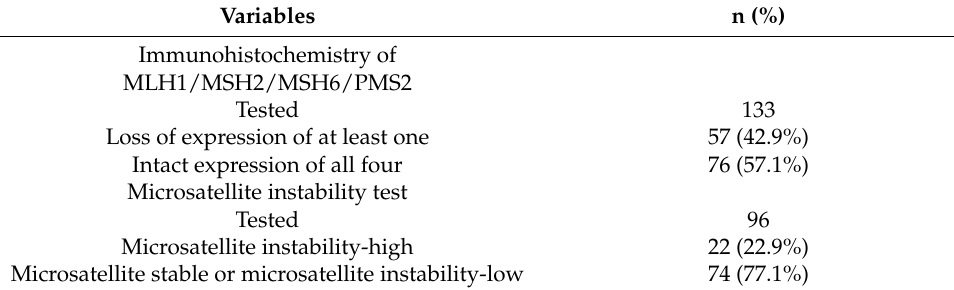
FIGO, International Federation of Gynecology and Obstetrics; LS, Lynch syndrome. * Lynch syndrome-associated cancers: colorectal, ovarian, stomach, pancreatobiliary, urinary tract, small bowel, and brain (usually glioblastoma) cancer; sebaceous carcinoma, keratoacanthoma. ** Family history of Lynch syndrome-associated cancers within second-degree relatives. Thirty patients (14.7%) were found to have pathogenic or likely pathogenic variants